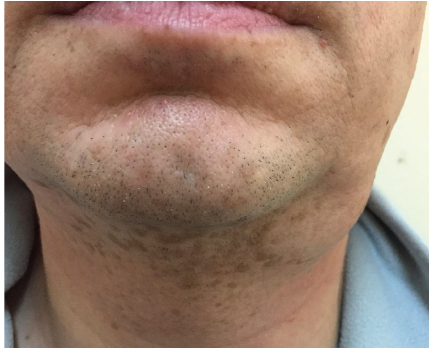
Figure 1: A mass in the left submandibular region.